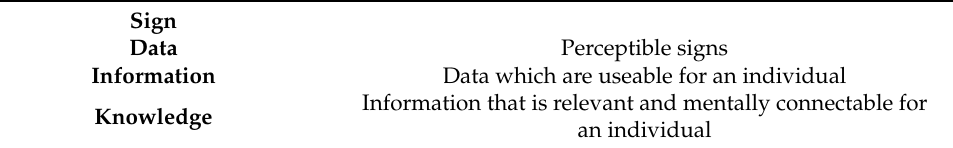
Table 1. Knowledge pyramid (c.f.